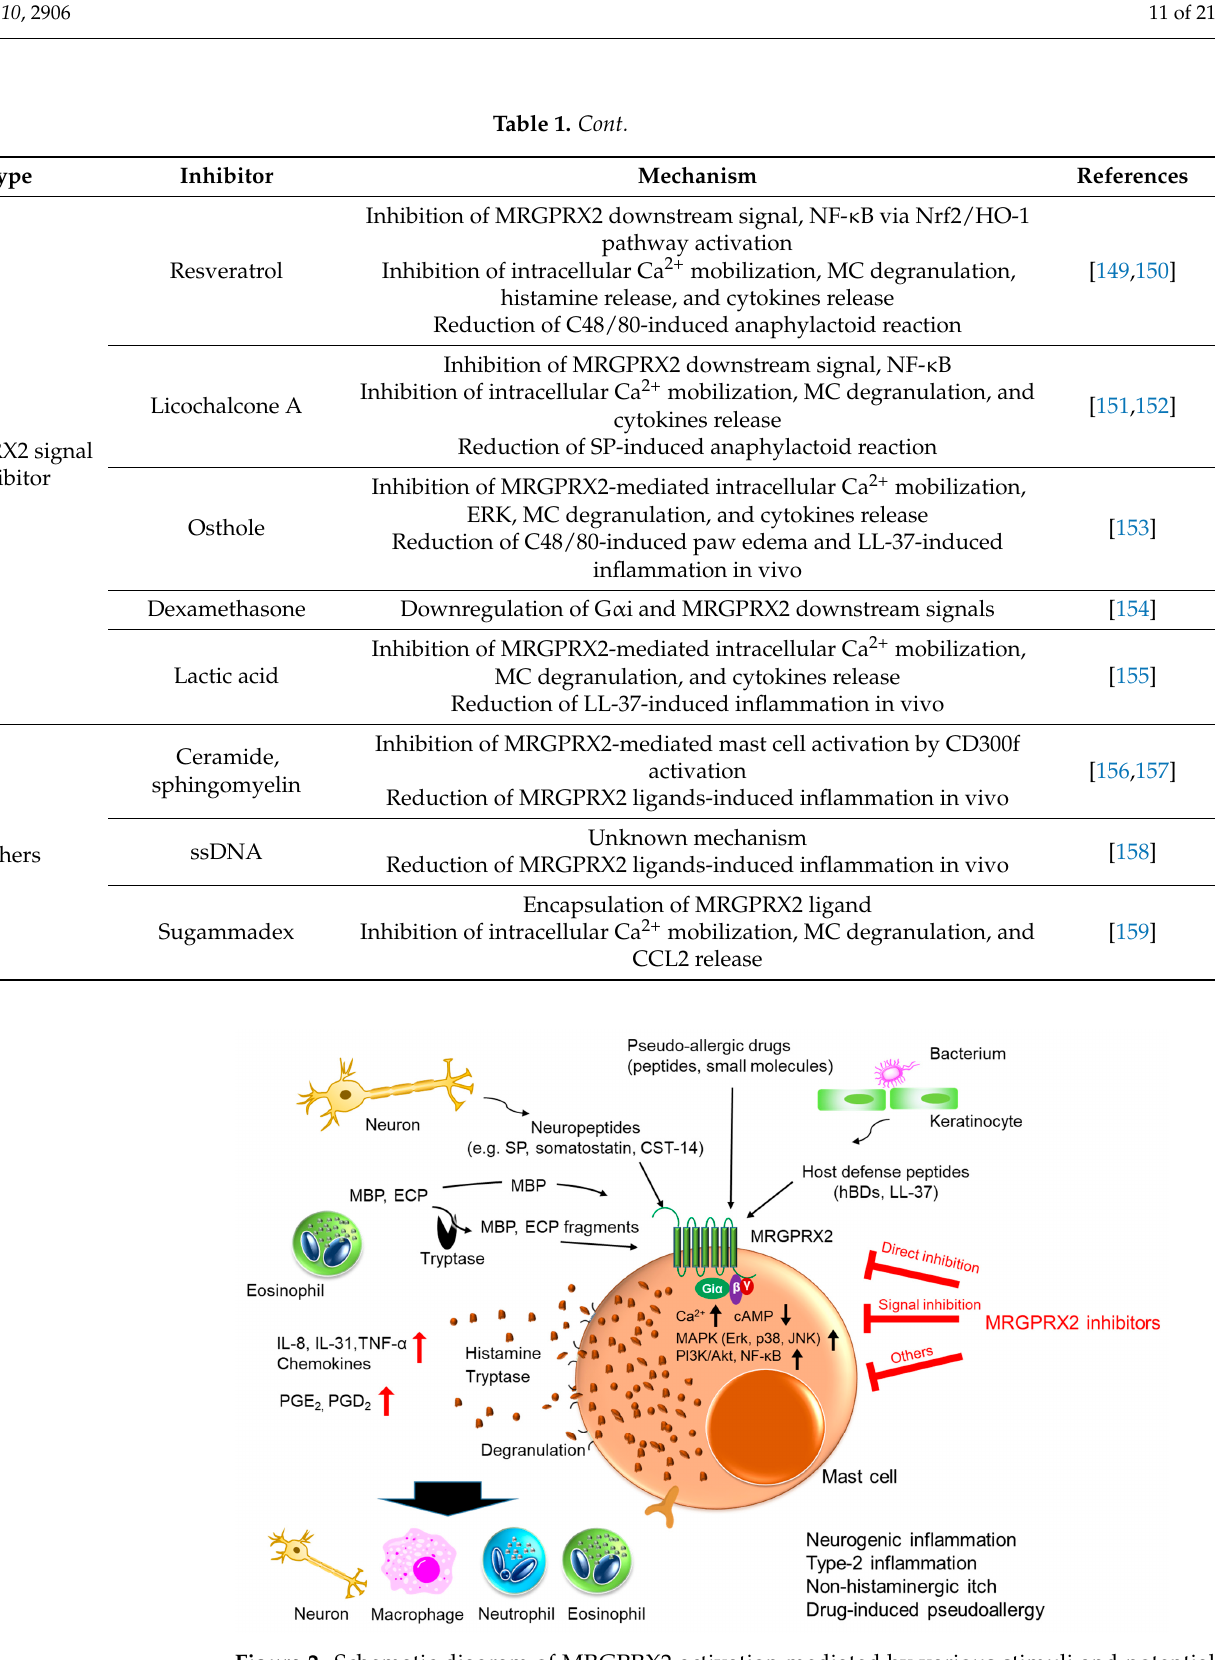
Figure 2. Schematic diagram of MRGPRX2 activation mediated by various stimuli and potential effects of MRGPRX2 inhibitors for induced diseases. MRGPRX2 is stimulated with various ligands and is thought to play important roles in neurogenic inflammation, type 2 inflammation, non-histaminergic itch, and drug-induced pseudoallergy through mast cell activation. MRGPRX2 inhibitors, which are divided into three categories, 1) direct inhibition of MRGPRX2, 2) inhibition of MRGPRX2 downstream signaling, and 3) other mechanisms, are expected to improve these diseases.